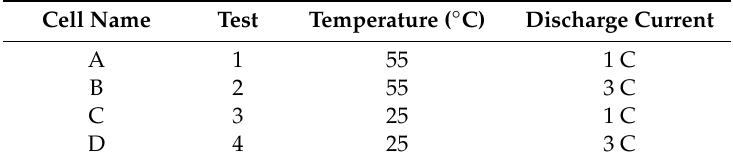
Table 2. Test conditions for the batteries.